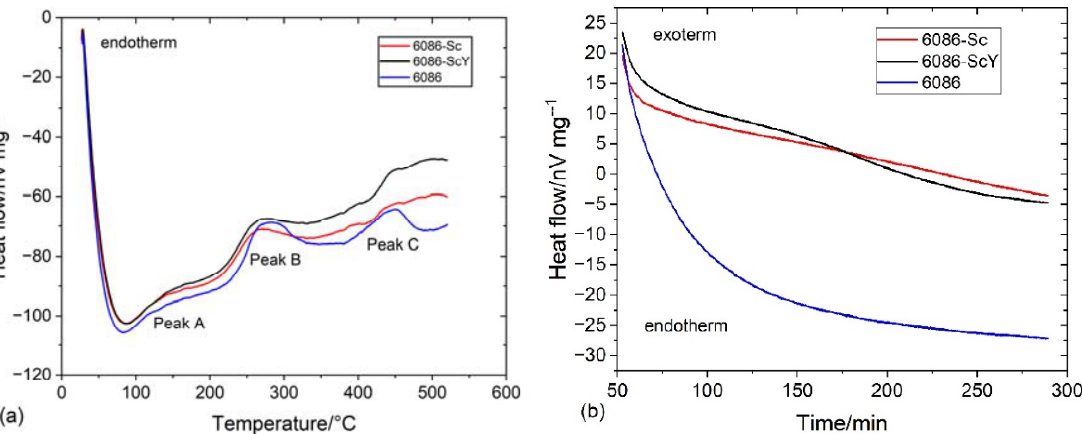
Figure 4. Heat fl ow by DSC tests of the investigated alloys ( a ) during heating from RT to 520 °C with 10 °C/min, and ( b ) during holding at 520 °C for 4 h.